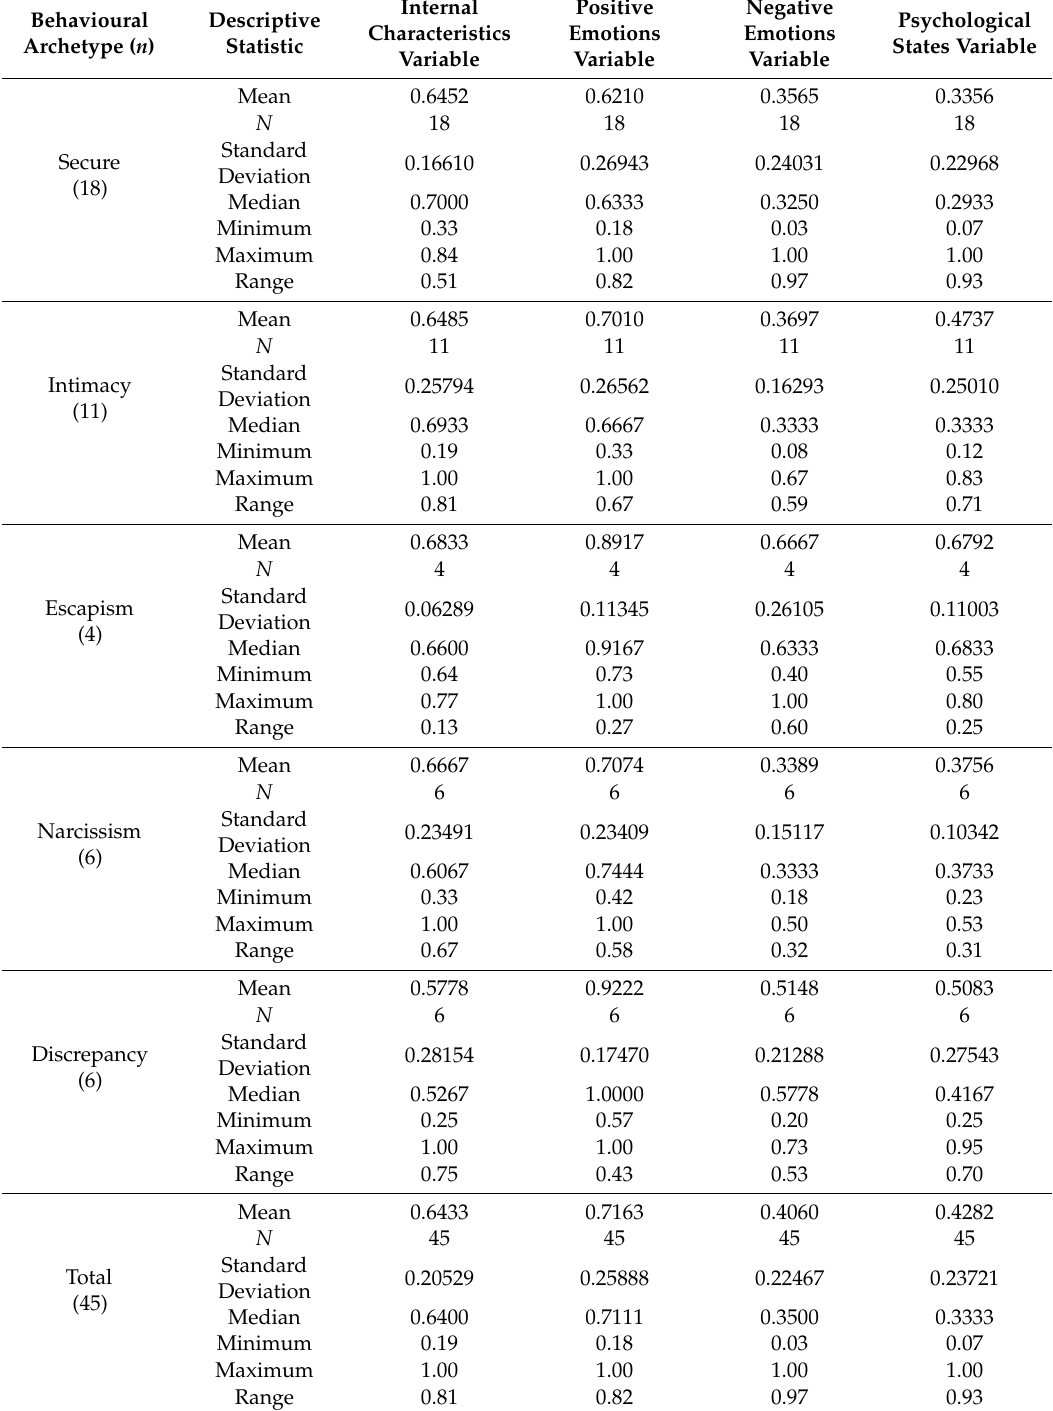
Table 16. Behavioural archetype